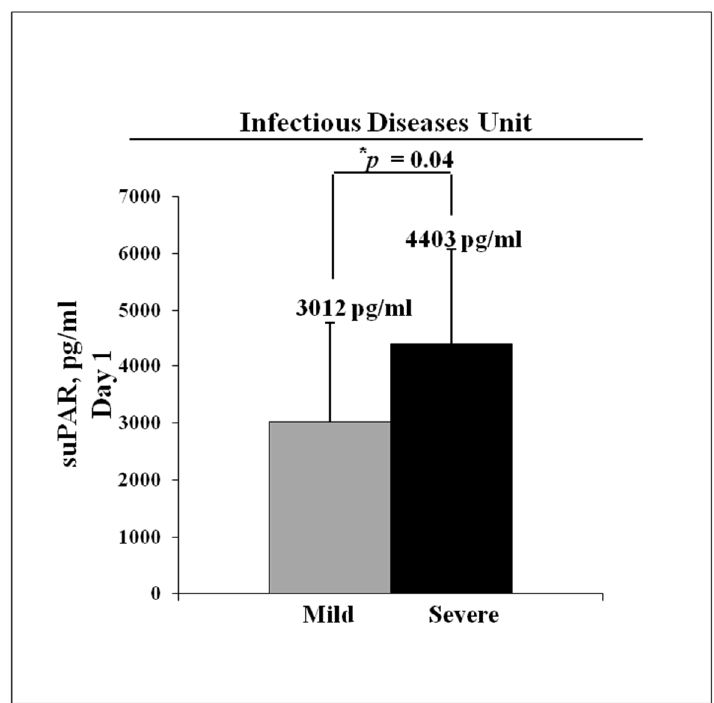
Figure 4. Analysis of serum suPAR levels in hospitalized COVID-19 patients during Italian first wave. suPAR measurements were performed by ELISA method on serum suPAR within 24 h of admission to Infectious Disease Unit. Asterisk indicates statistical significance between nine mild cases (grey column) and nine severe cases (black column) of COVID-19, determined by the Student t-test (* p < 0.05). Table 4. Clinical characteristics and laboratory data of ICU patients during the Italian first